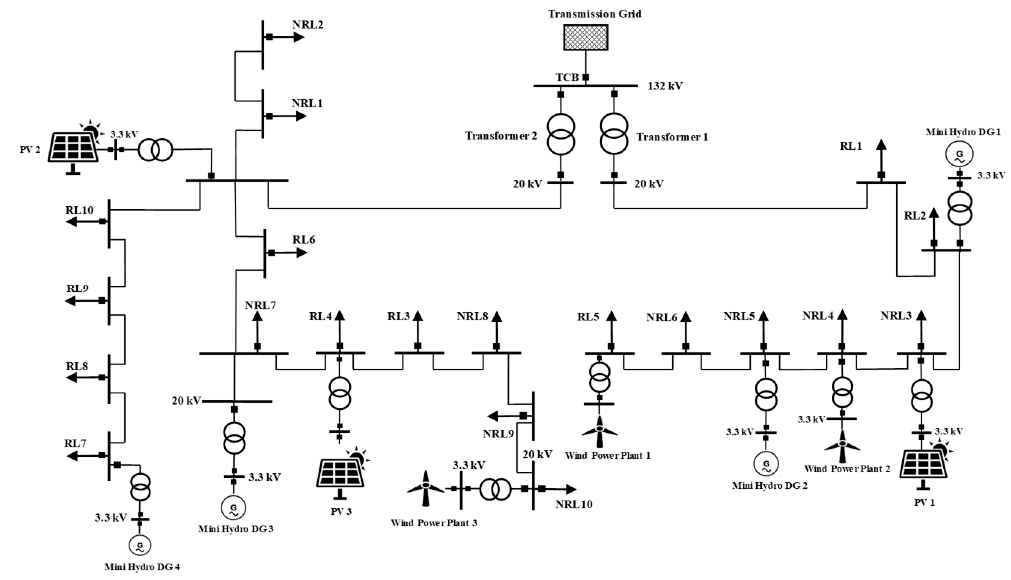
Table 5. Optimization against dynamic simulations comparison: the base configuration.